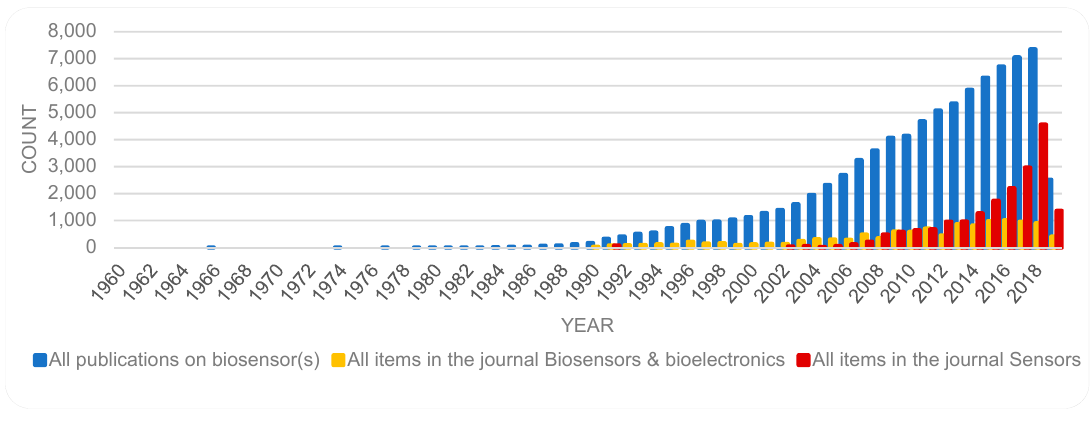
Figure 3. Yearly number of publications on biosensors (85,174 items) as compared with total publications in the journals Biosensors & bioelectronics (11,794 items) and Sensors (18,997 items) based on data retrieved from WoS on 8 May 2019.